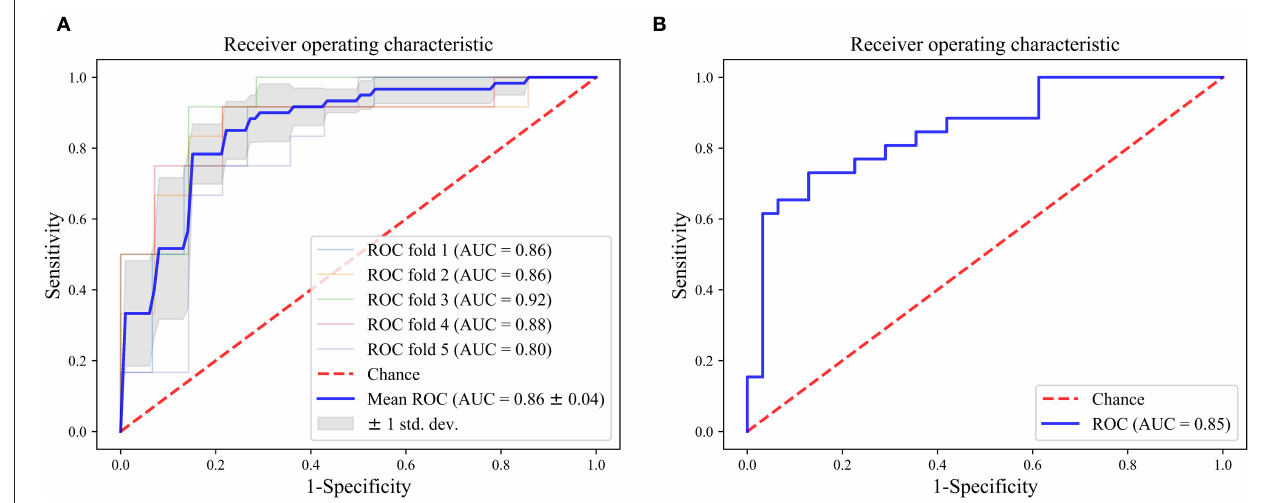
FIGURE 4 | ROC curves of the optimal model (T2WI-DLR). (A) training cohort; (B) test